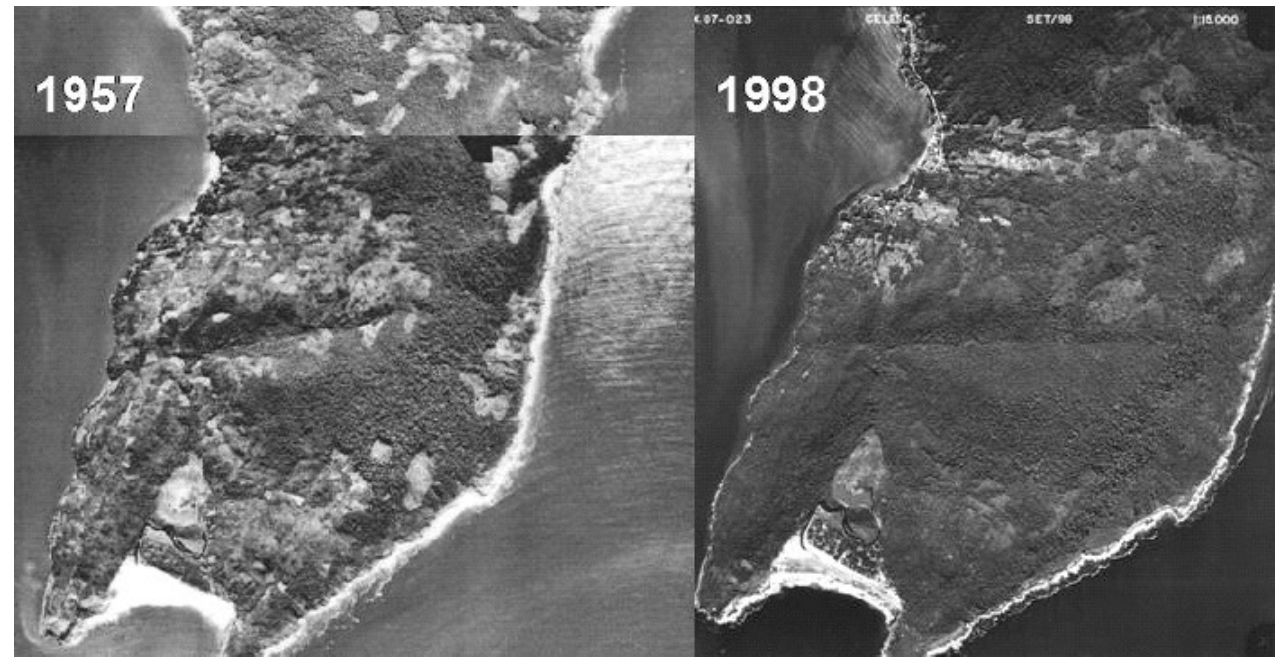
Fig. 8. Forest recovery after agricultural abandonment and the creation of a protected area at the southern extreme of Santa Catarina Island. Source: Instituto de Planejamento Urbano de Florianópolis (Florianópolis Urban Planning